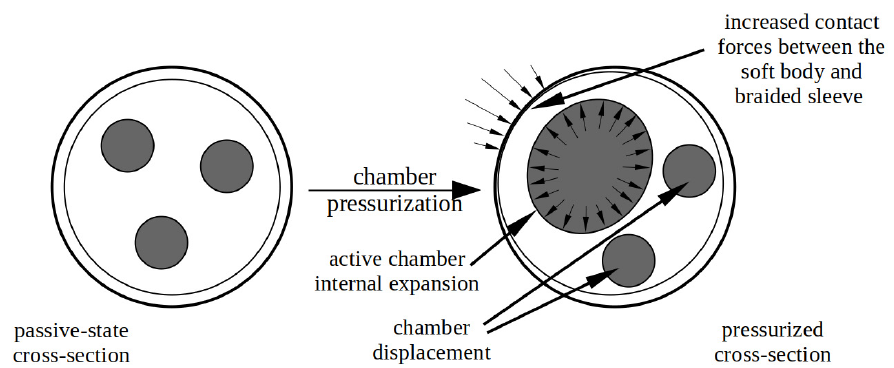
Figure 7. Deformation of module cross-section during actuation. Pressurization of any chamber causes it to expand within the braided sleeve that leads to significant deformation of the cross-section of the module. The deformation includes the expansion of the chamber itself, displacement of other chambers and increased pressure between the silicone body and the sleeve [28].